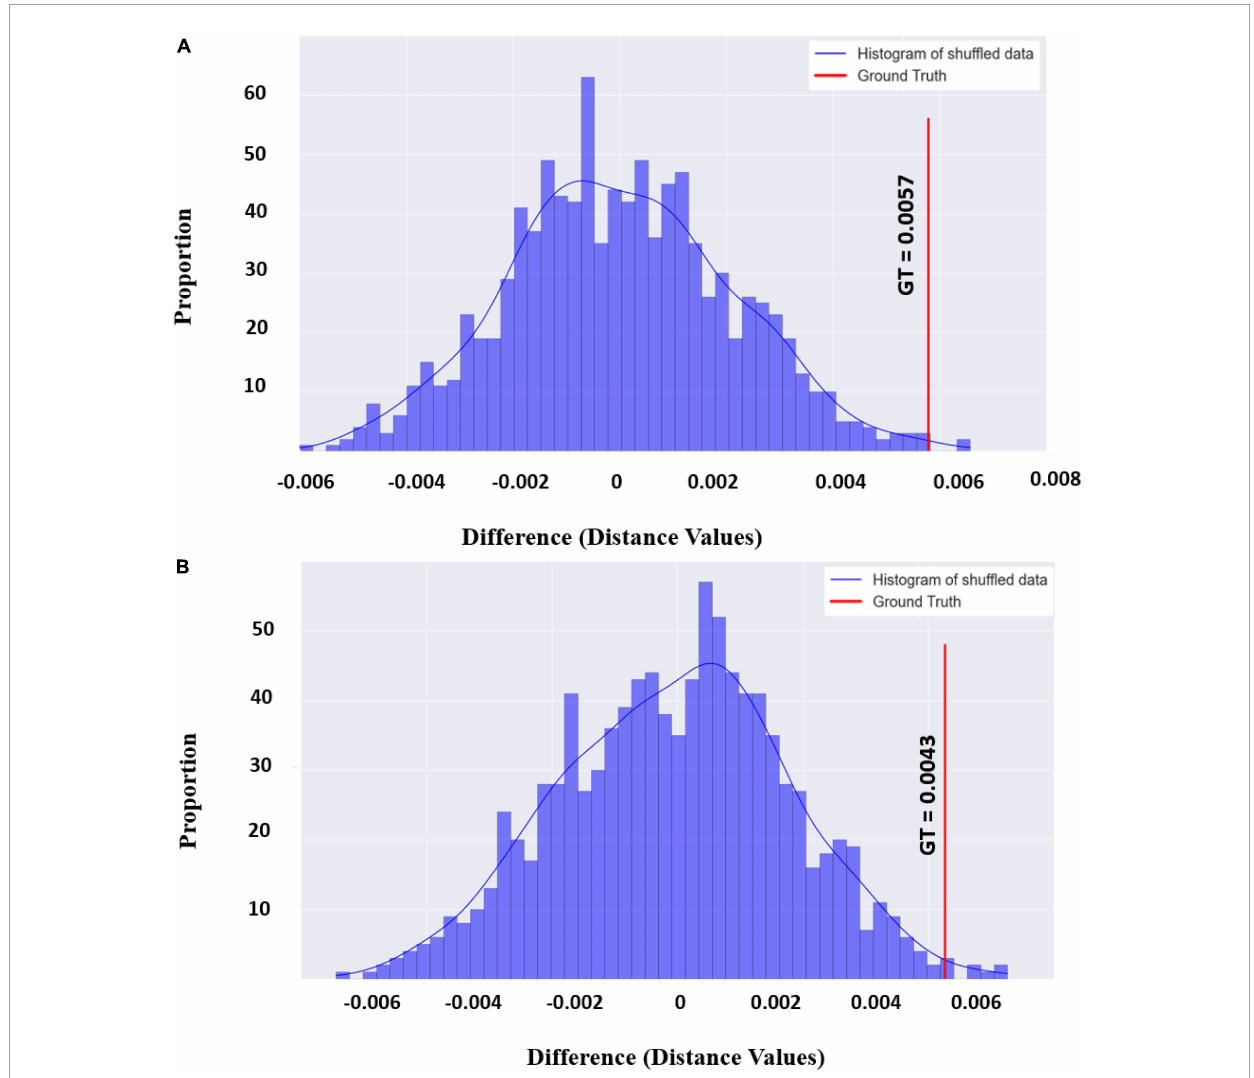
FIGURE3 (A) The distribution and ground truth values of the beta asymmetry score differences in the two conditions (purchase vs. Non-purchase). The distribution derives from calculating the difference of the beta asymmetry score between two conditions for 1,000 times and shuffling the labels among trials. The blue vertical line is our ground truth which indicates the same difference but for the actual conditions. (B) Same as the above plot but for planned and unplanned conditions in gamma frequency